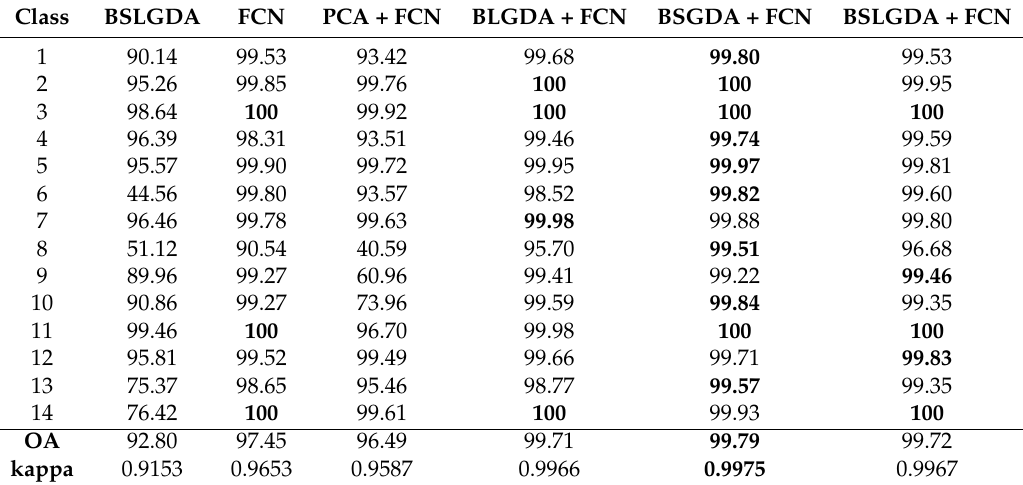
Table 3. SVM class-specific accuracy (%), OA and kappa coefficient of different methods for the Flevoland Benchmark data